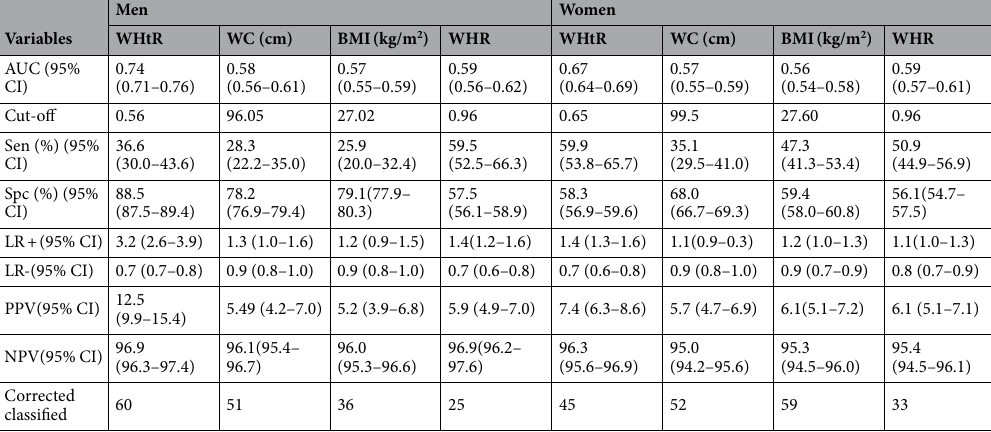
Table 2. Area under the receiver operating characteristic curve (and 95% confidence interval) and optimal cut-off values of diagnostic measures of anthropometric indices against CVD stratified by sex. AUC area under the ROC curve, Sen sensitivity, Spc specificity, LR likelihood ratios, WC waist circumference, BMI body mass index, WHR waist to hip ratio, WHtR waist to height ratio. There are no significant difference among AUCs ( df = 3) = 130, P = < 0.001, ( df = 3) = 336, P = < 0.001 in men and women respectively. Data are AUC (95% confidence interval).